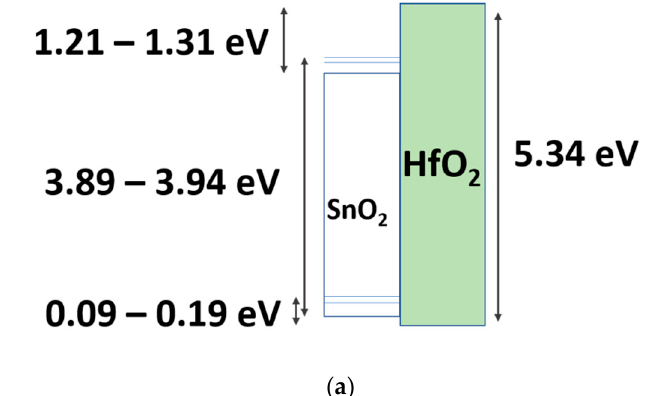
Figure 5. XPS analysis used for the calculation of the band offsets for the various SnO 2 curing tem- peratures. ( a , e , i ) the Hf 4f at the interface of SnO 2 /HfO 2 , ( b , f , j ) the Sn 3 d 5/2 peak at the SnO 2 /HfO 2 in- terface, ( c , g , k ) the Sn 3 d 5/2 at the top of the SnO 2 surface, ( d , h , l ) the valence band of SnO 2 at the top of the SnO 2 surface. The first second, and third line shows the peaks for the SnO 2 thin film cured at 200, 280, and 350 °C respectively. The peaks and curing conditions are indicated within the figures. The red lines in each graph shows the value of the peak extracted and used for the calculation of Δ E v .